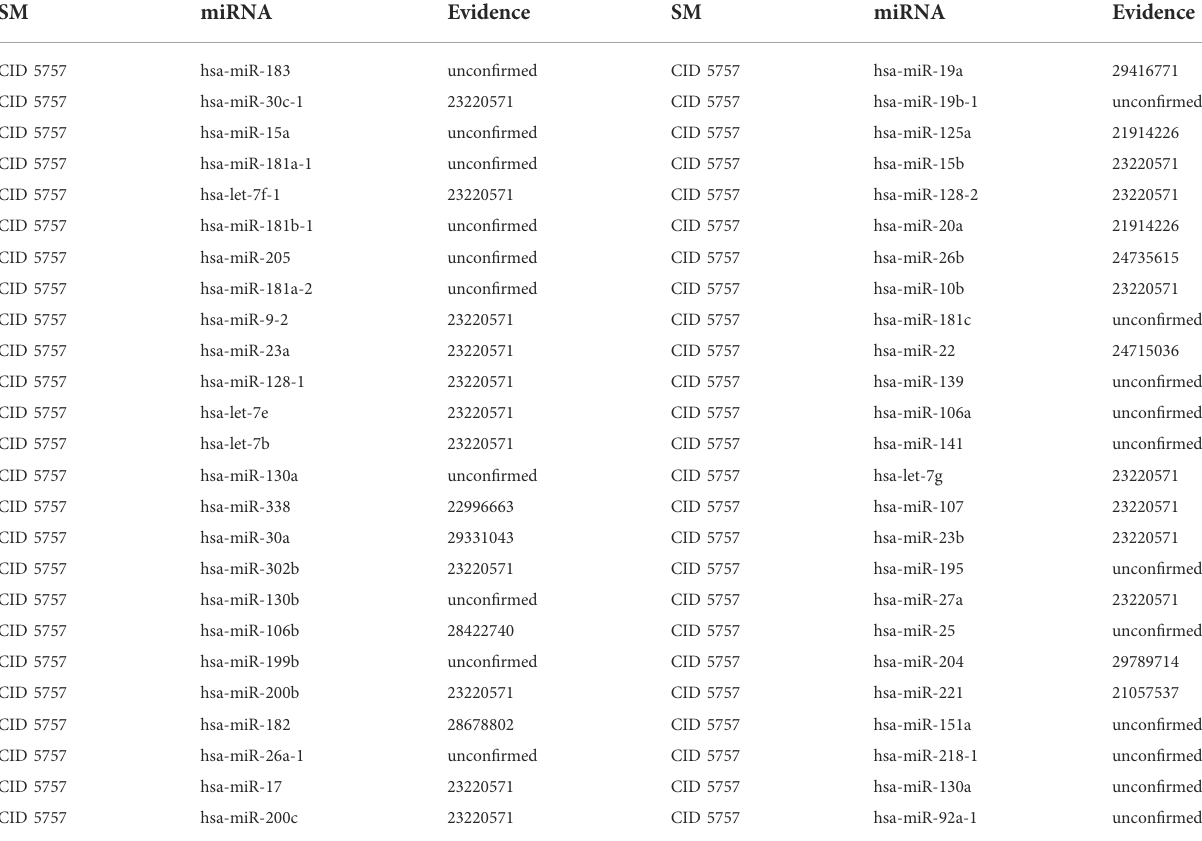
TABLE8Validationofthetop50miRNAsassociatedwithE2inthesecondtypeofcasestudies.The fi rstcolumnrecordsthetop1 – 25relatedmiRNAs. The second column records the top 26 – 50 related